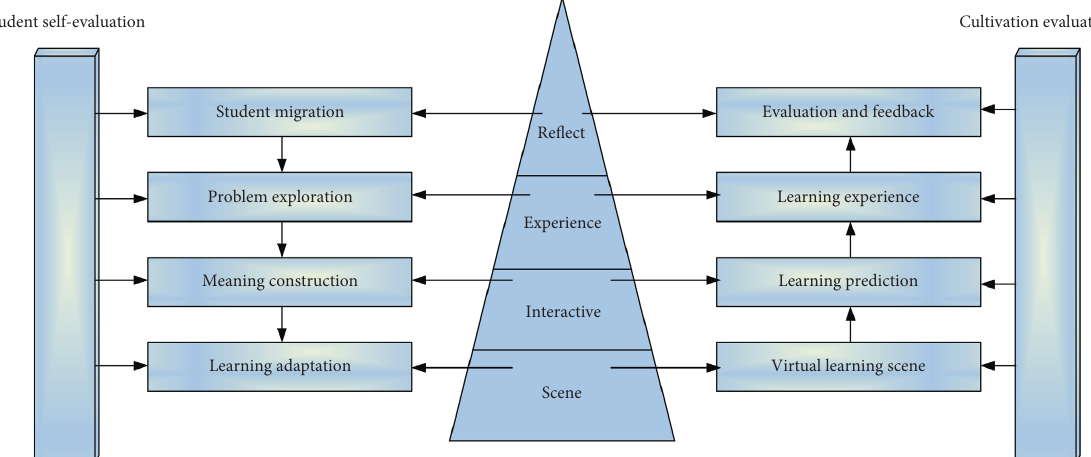
Figure 5: Construction of immersive XR teaching space.